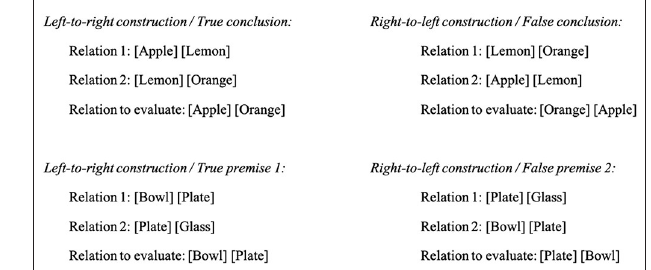
FIGURE 3 | Illustration of the sequence of events and the two directions of construction. FIGURE 4 | Illustration of the four types of